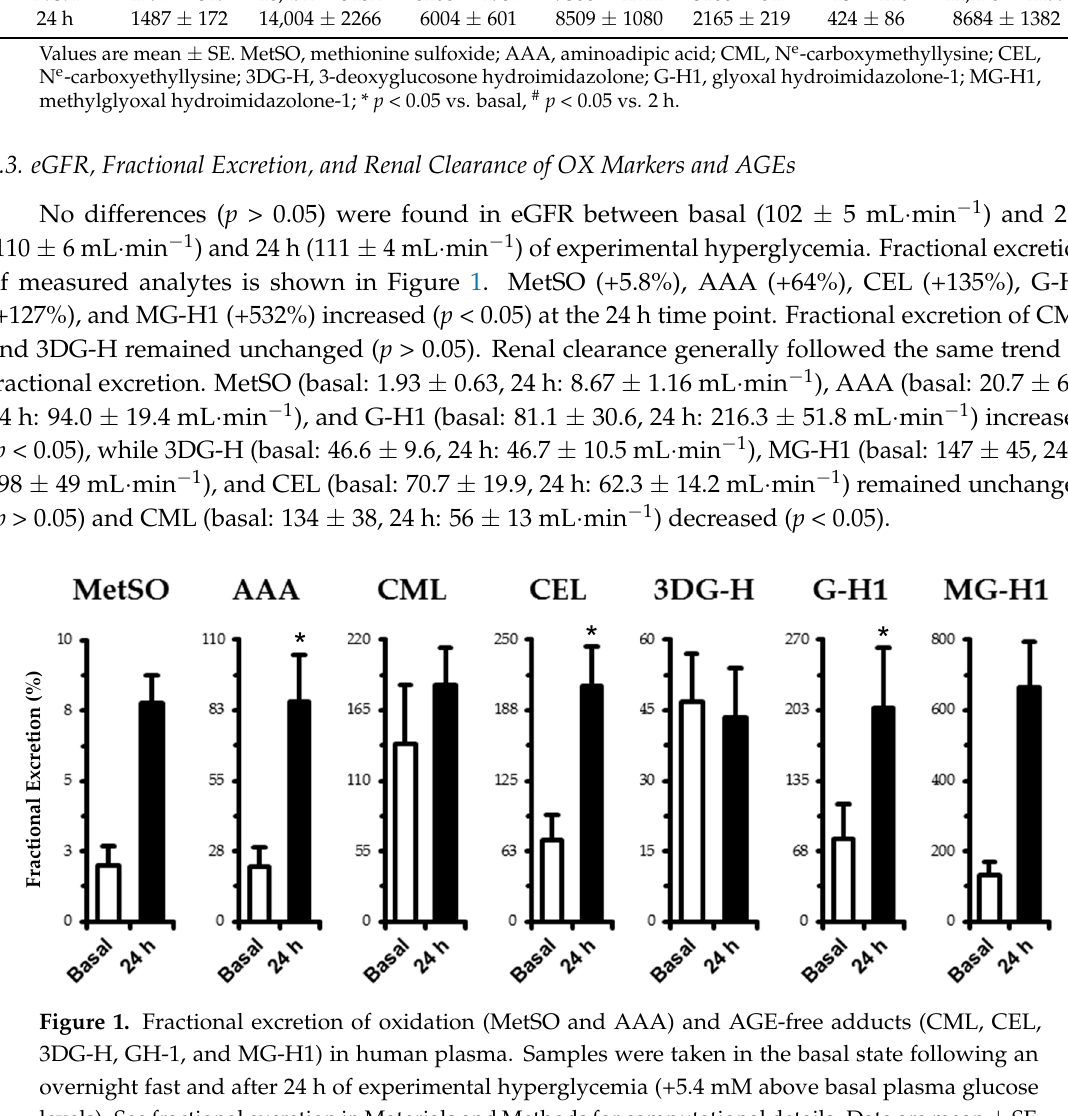
Table 3. Plasma inflammatory marker, total sRAGE, and sRAGE isoform concentrations.